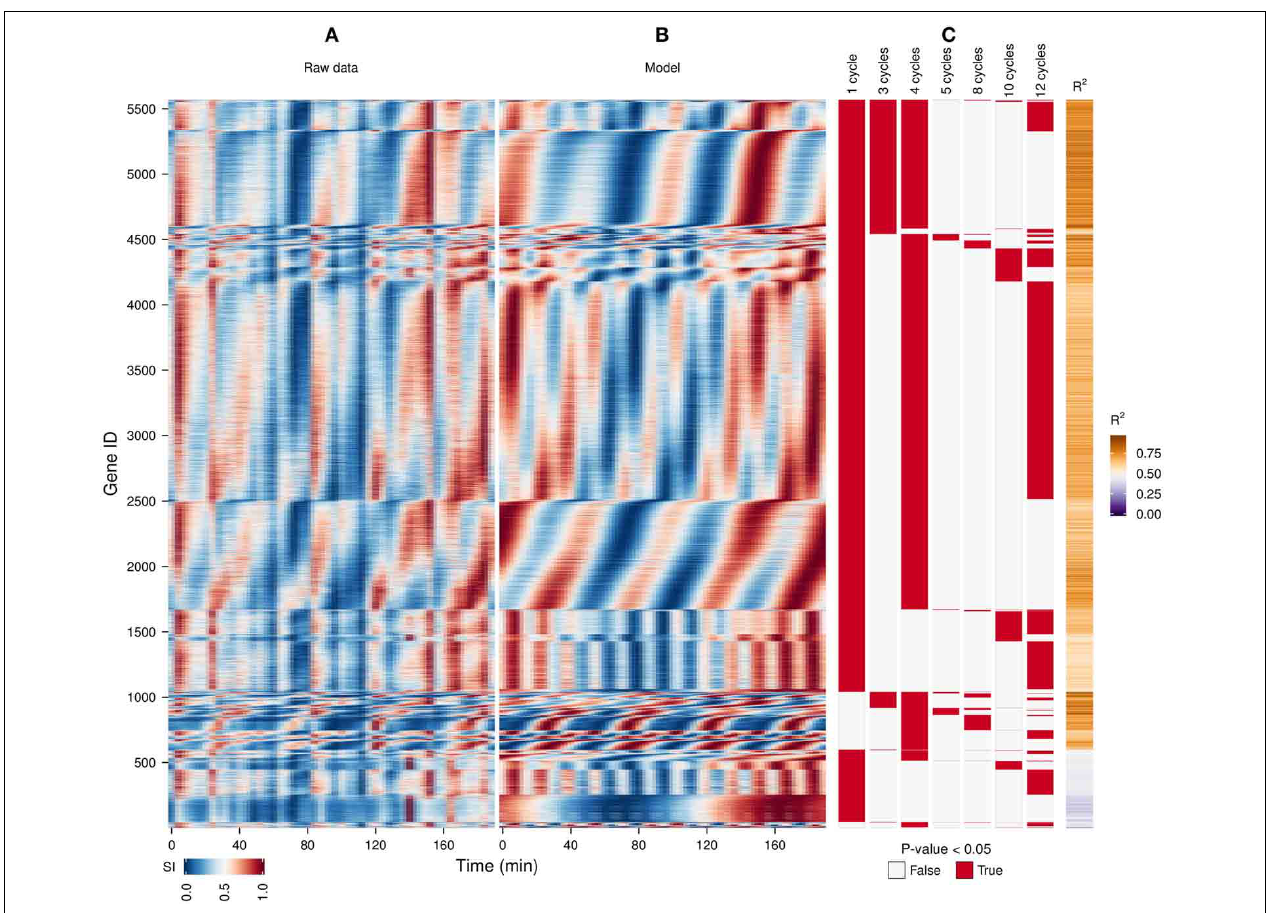
FIGURE 3 | Identification of expression cohorts using major spectral powers. The waveform algorithm was used on a raw transcriptome dataset (A) taken during a perturbation experiment (injection of 1mM phenelzine at min 48) (Li and Klevecz, 2006) to generate a model using the default settings ( B ; R 2 values shown in sidebar). Genes were first sorted according to the